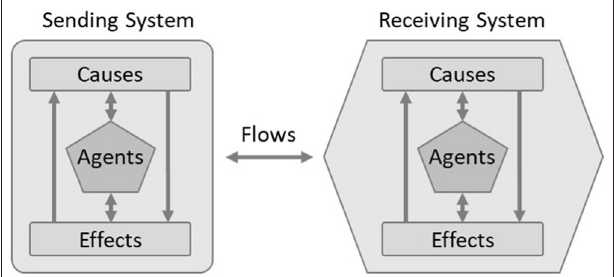
FIGURE 1 | Telecoupling framework with the five main components (without spillover system). At the telecoupled system level, the framework consists of two or more coupled systems that are connected through flows among them (termed sending and receiving system). At the coupled system level, each coupled system consists of three interrelated components: agents, causes, and effects. Adapted from Liu et al.